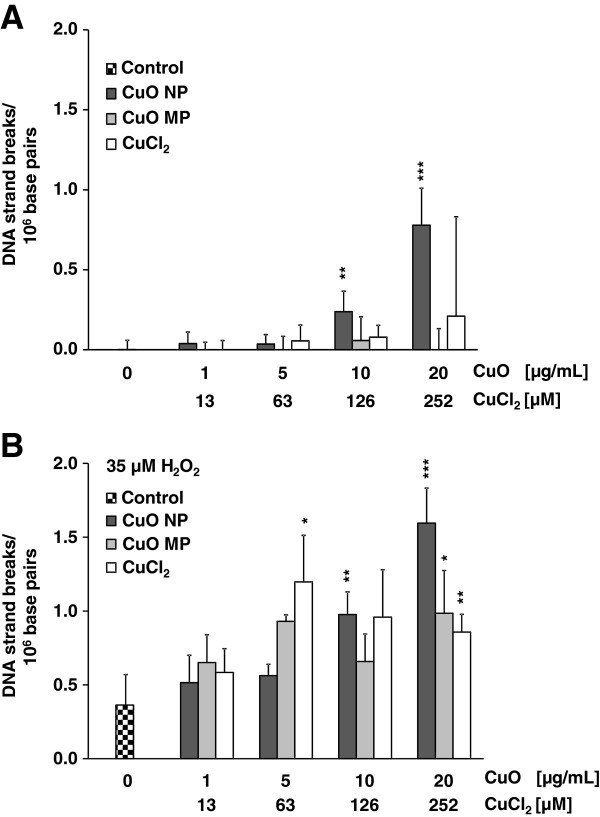
Induction of DNA strand breaks by CuO NP, CuO MP or CuCl2 in the absence and presence of H2O2. Logarithmically growing HeLa S3 cells were preincubated with CuO NP, CuO MP or CuCl2 for 24 h alone (A) or in combination with 35 μM H2O2(B) for 5 minutes in the continued presence of CuO NP, CuO MP or CuCl2. DNA strand breaks were quantified by Alkaline Unwinding as described in Materials and methods. The data represent mean values of 3 determinations + SD. Statistically significant different from control (A) or from H2O2-treated cells in the absence of copper compounds (B): *p < 0.05, **p < 0.01, ***p < 0.001 as determined by unifactorial analyis of variance (ANOVA) followed by Dunnet's T3 test. 1 μg/mL are equal to 0.2 μg/cm2 and 20 μg/mL CuO are equal to 252 μM Cu2+ in case of complete dissolution.